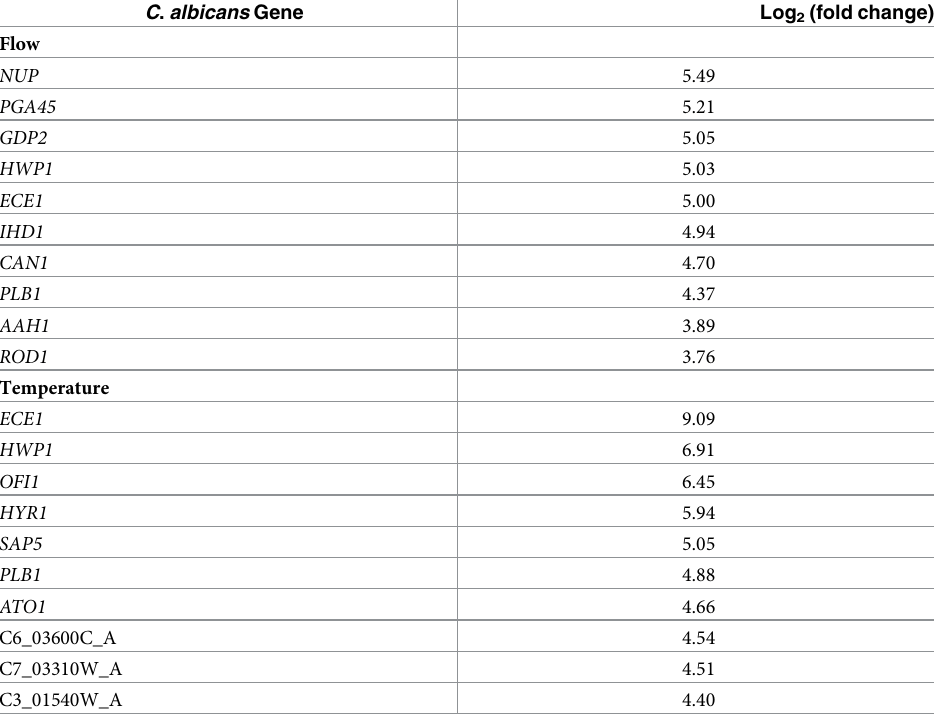
Table 1. C . albicans most highly upregulated genes in microcolonies induced by flow and temperature. Ten genes with the highest fold change for Flow and Temperature datasets from RNA-seq